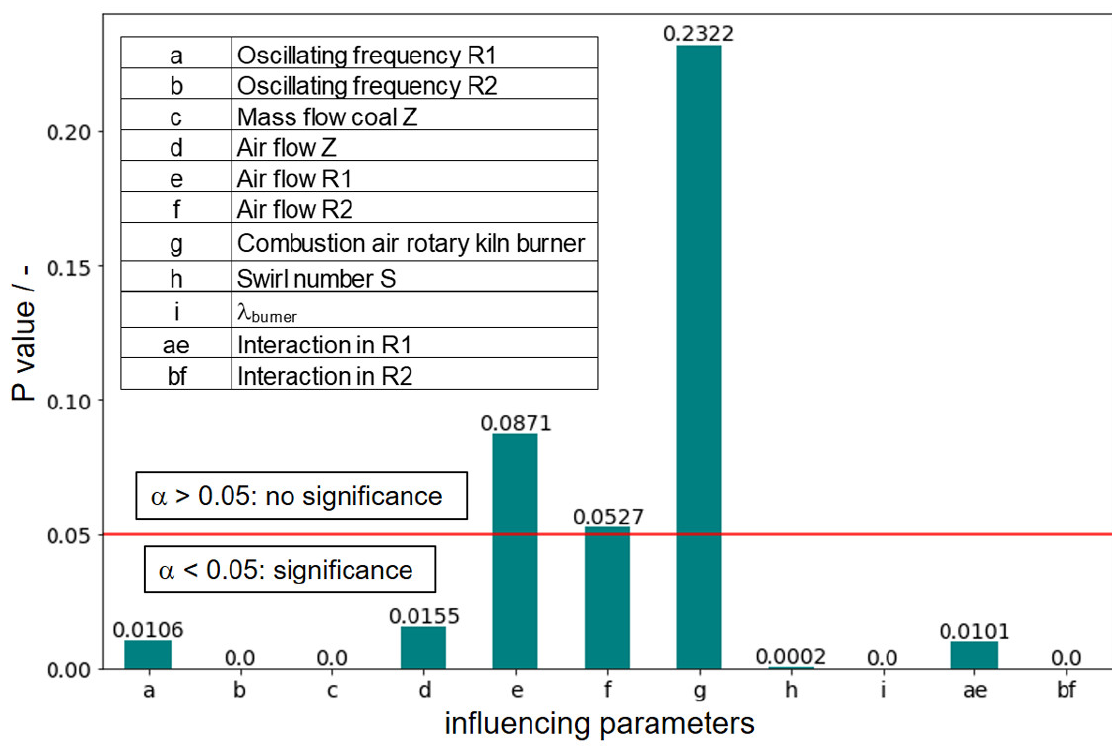
Figure 9. p -Value of influencing variables.